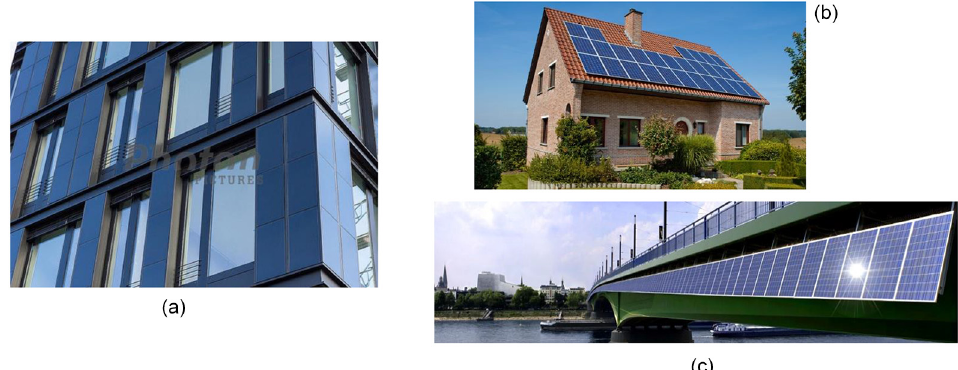
Fig. 19. A, B, and C are in Cologne (cid:1) Germany. A- CIGS thin fi lms, façade cladding testing, Project, Research Baden-Württemberg. C- A bridge in Germany, CIGS (cid:1) thin fi lms.